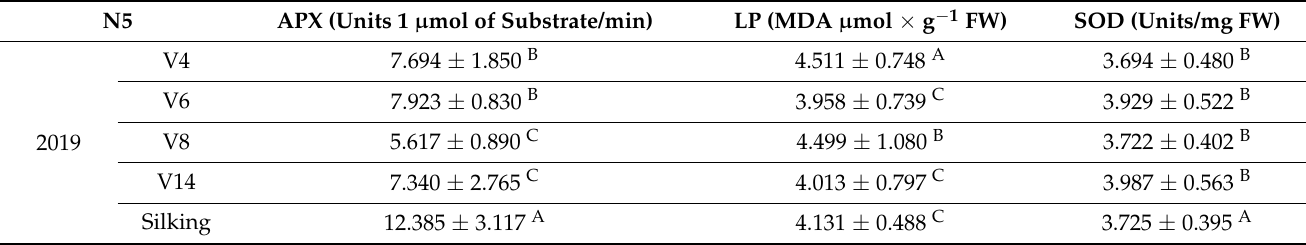
V4 = four-leaf stage, V6 = six-leaf stage, V8 = eight-leaf stage, V14 = fourteenth-leaf stage, Silking= silking phenological stage. APX (Unit) was defined as the amount of enzyme that oxidized 1 µ mol of substrate/min), LP: lipid peroxidation (MDA µ mol × g − 1 FW), SOD (units/mg FW) FW: fresh weight (means ± Standard deviation). Table 2. Tukey pairwise comparisons the effect of the different sampling time and years for the APX: ascorbate peroxidase, SOD: superoxide dismutase activity and the LP: lipid peroxidation under 300 kg ha − 1 N fertilizer with high-level P and K. Treatments with the same letter are not significantly